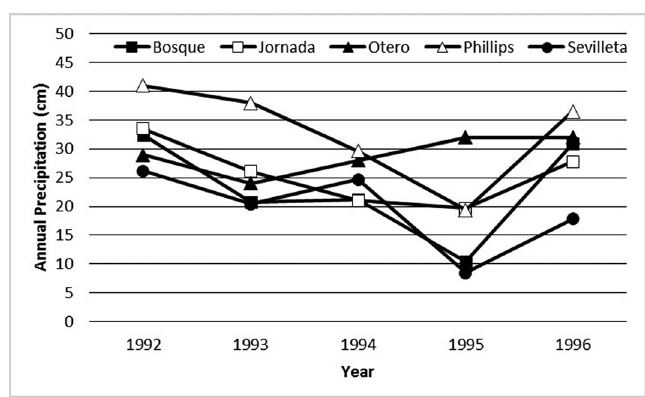
Fig. 1. Total annual precipitation (January-December) at each of the study sites over the five-year study period.